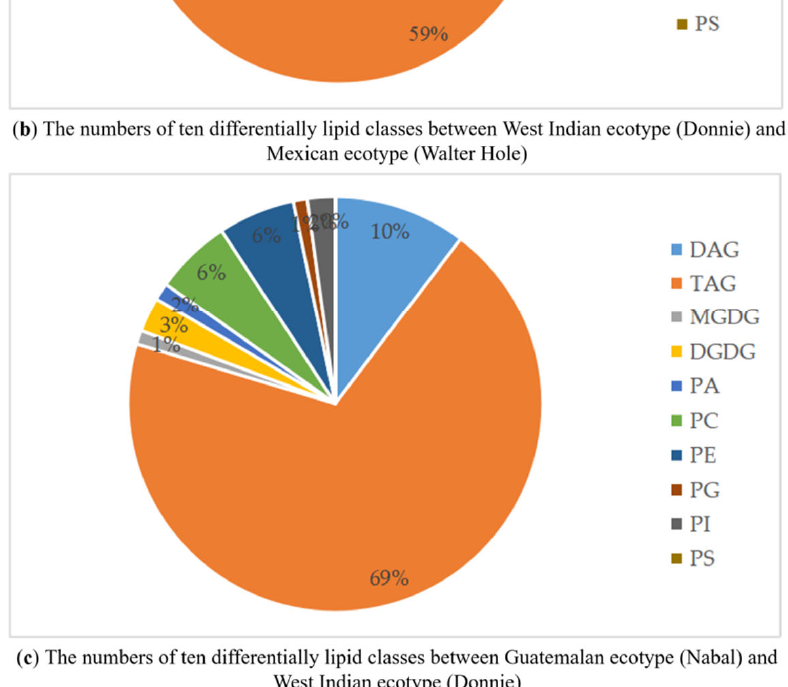
Figure 5. Proportion of differentially accumulated lipids in ten classes among the mature avocado mesocarps of three ecotypes.